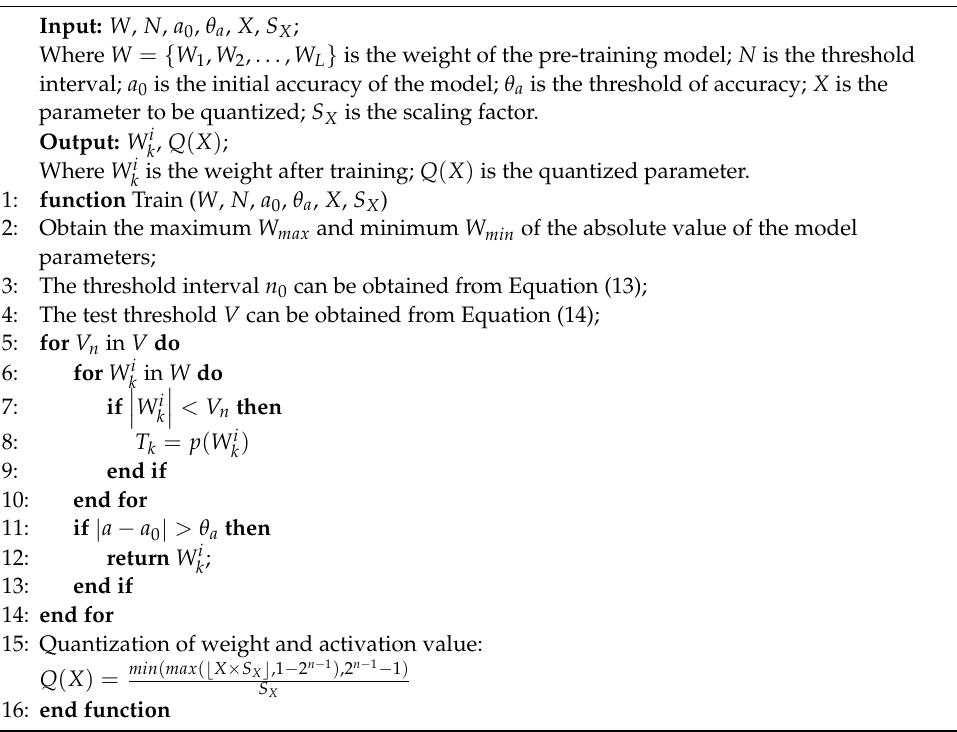
Algorithm 1. Network pruning and quantization